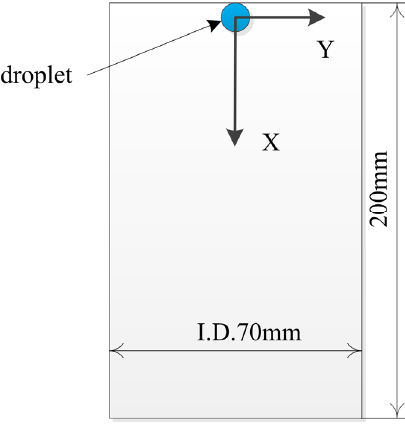
Figure 5. Test Figure 5. Test section.